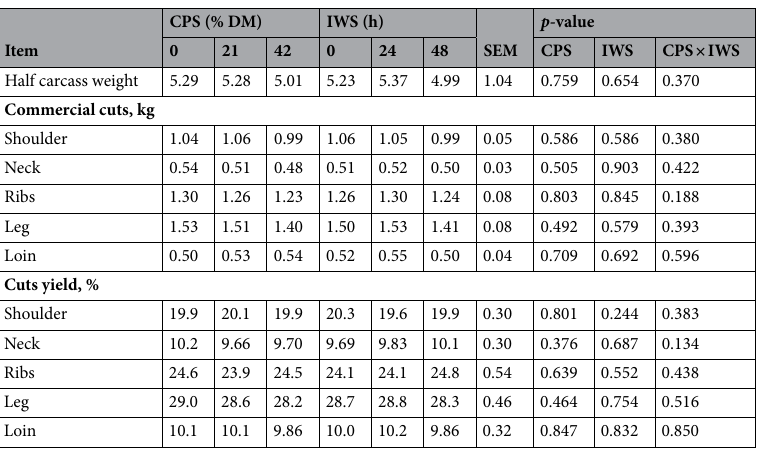
Table 2. Half cold carcass and weight of commercial cuts of goats fed with cactus pear silage (CPS) and submitted to intermittent water supply (IWS).